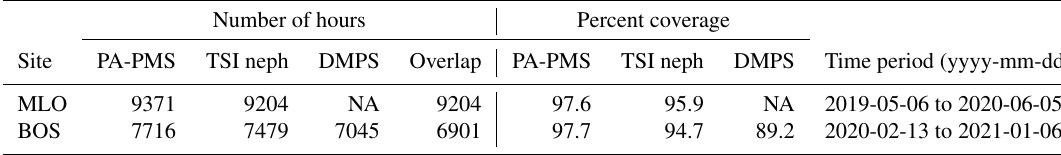
Table 1. Summary of PA-PMS, TSI nephelometer, and DMPS data coverage. NA – not available.